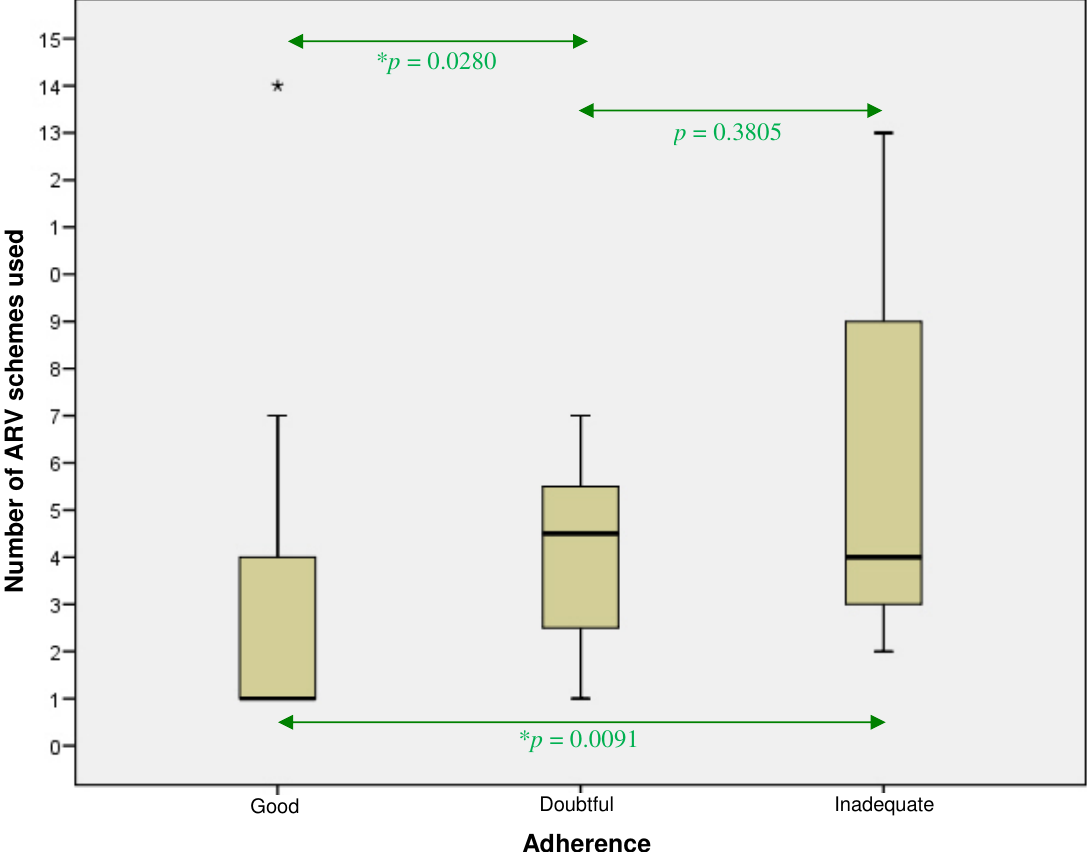
FIGURE 2. Boxplot showing number of antiretroviral schemes distribution consistent with therapy adherence. * p < 0.05 = statistically